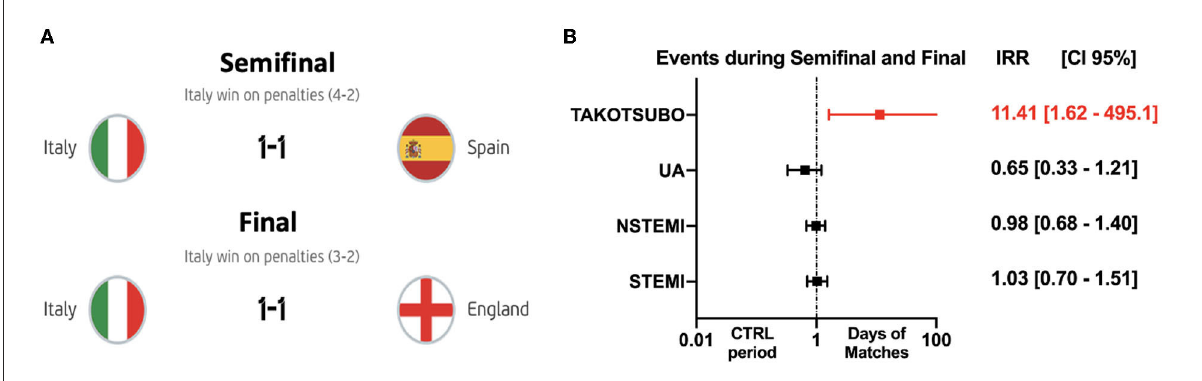
FIGURE1 Incidence rate ratios for ACE on days during the semifinal and final of UEFA Euro 2020 Football Championship, as compared with days during the control period. ACE during the semifinal and final, the most stressful matches ended with penalties, and the victory of the Italian team against Spain and England (A) , showed a much more relevant increase in the incidence of Takotsubo Syndrome by a factor of 11.41 ( p < 0.003) as compared with the control period. No differences were found in the incidence of ACS ( P = 0.57) (B) .